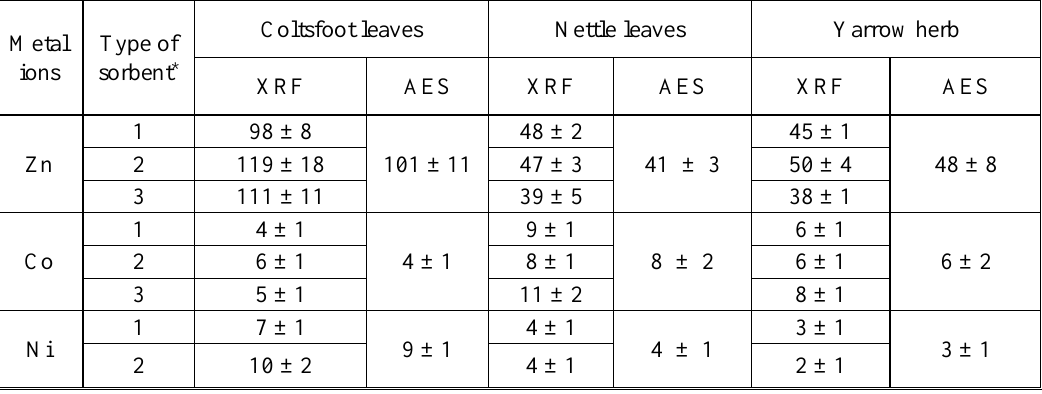
* 1 - PUF, modified by resorcinol 2 - PUF, modified by 8-hydroxyquinoline 3 - PUF, modified by 2- nitrozo-1-naphthol Table 3. Results of trace element determination in vitamin-mineral complexes (µg/g, n = 5, P =